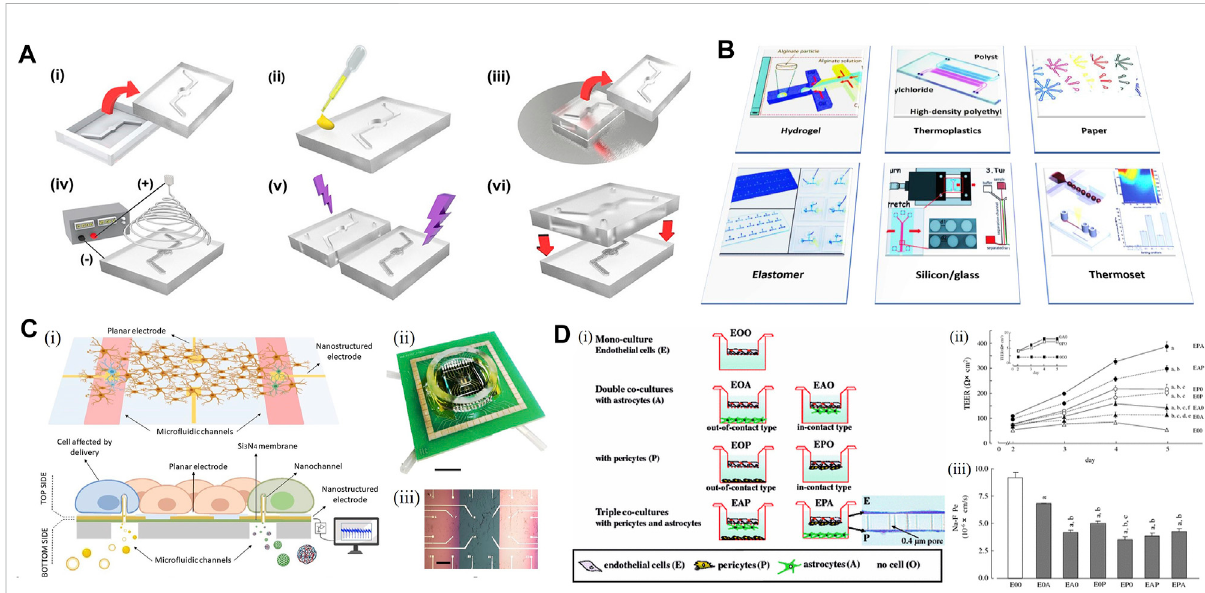
FIGURE 4 Micro fl udic chip for the in vitro model. (A) Schematic representation of the fabrication process of a PDMS-based chip. [(A), i] Top and bottom PDMS micro fl uidic channel substrates are formed by pouring PDMS mixtures into a mold and demolding it from the master mold. [(A), ii] Coating PDMS substrate with silver nanowires (AgNW) solution on top of the bonding interface. [(A), iii] Stamping PDMS substrate on spin-coated uncured PDMS layer forming an AgNWs-embedded uncured PDMS adhesive layer. [(A), iv] Direct electrospinning nano fi bers to the bottom PDMS micro fl uidicchannelsubstrate. [(A),v] Formingafree-standingpolycaprolactone(PCL)nano fi bermembraneonthechannelarea. [(A),vi] Integration of nano fi ber membrane-deposited PDMS substrate with top PDMS micro fl uidic channel substrate by the free-standing PCL nano fi ber membrane. Adapted with permission. (Rhyou et al., 2021) Copyright © 2021, American Chemical Society. (B) Schematic illustration of the materials used for the fabricationofmicro fl uidic chipsinneurodegenerativestudiessuchas Alzheimer ’ sdisease (Prasannaetal.,2021).Hydrogelsserve asmatrices forcell culture in micro fl uidic chips. (C) Micro fl uidic device with planar and nanostructured electrodes. [(C), i] Scheme of the device. [(C), ii] Picture of the devicefromthetopside. [(C),iii] Topsurfaceindetail,withfeedlinesandelectrodesonthinsiliconnitridemembranes(pink)andbulksurface(green) (Bruno et al., 2020). (D) In vitro BBB model co-culturing rat brain capillary endothelial cells with pericytes and astrocytes. [(D), i] Schematic of BBB models. [(D), ii] Effectiveness of co-culture on the induction of transendothelial electrical resistance (TEER) in brain capillary endothelial cell monolayers of in vitro BBB models, with the left upper panel indicating a very low TEER of astrocytes ( fi lled square, 0A0) and pericytes (open square, 0P0)cultured ontheinserts. [(D), iii] Transendothelialpermeabilitychangesfortheparacellularpermeabilitymarkerinbraincapillaryendothelialcell monolayers of in vitro BBB models (Nakagawa et al.,